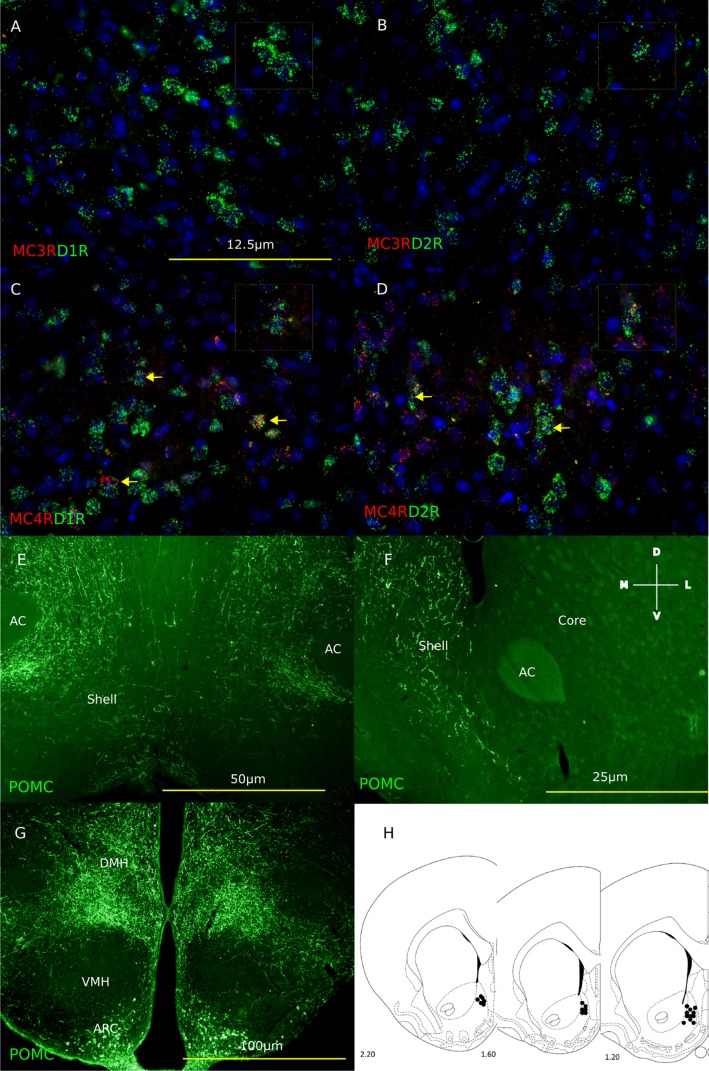
Melanocortin receptor signaling in the nucleus accumbens.Fluorescent in-situ hybridization with MC3 and MC4 receptors on rat brain slices containing the NAc shell. Nuclei were stained with DAPI and pseudocolored in blue and MC receptors are shown in red and D1/D2 receptors in green. Arrow indicates cells with prominent mRNA co-localization (A-D). POMC expression in the ARC (Bregma -3.30mm) (G) and in the NAc shell but not core regions (Bregma = +1.2mm) (E and F). Cannula placements within the NAc shell. Numbers indicate relative location from the bregma (H).